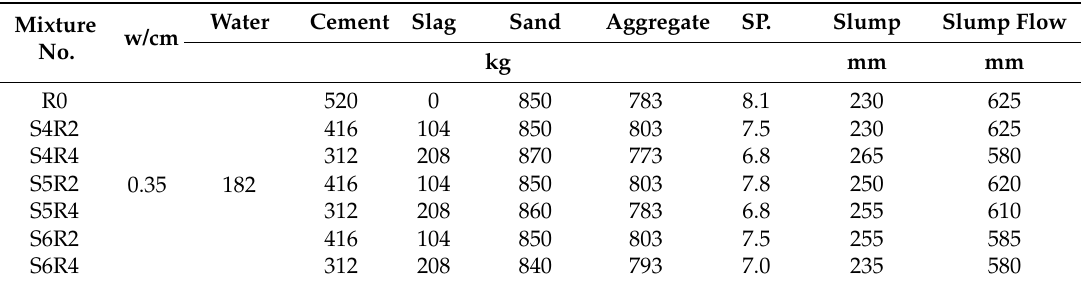
Table 2. Mixture proportions and properties of fresh